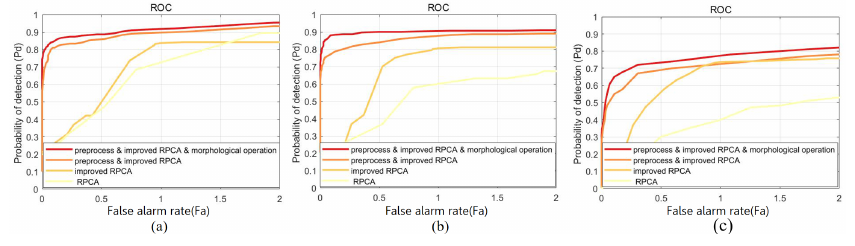
Figure 12. ROC curves of ( a ) Sequence 1, ( b ) Sequence 2, ( c ) Sequence 3.